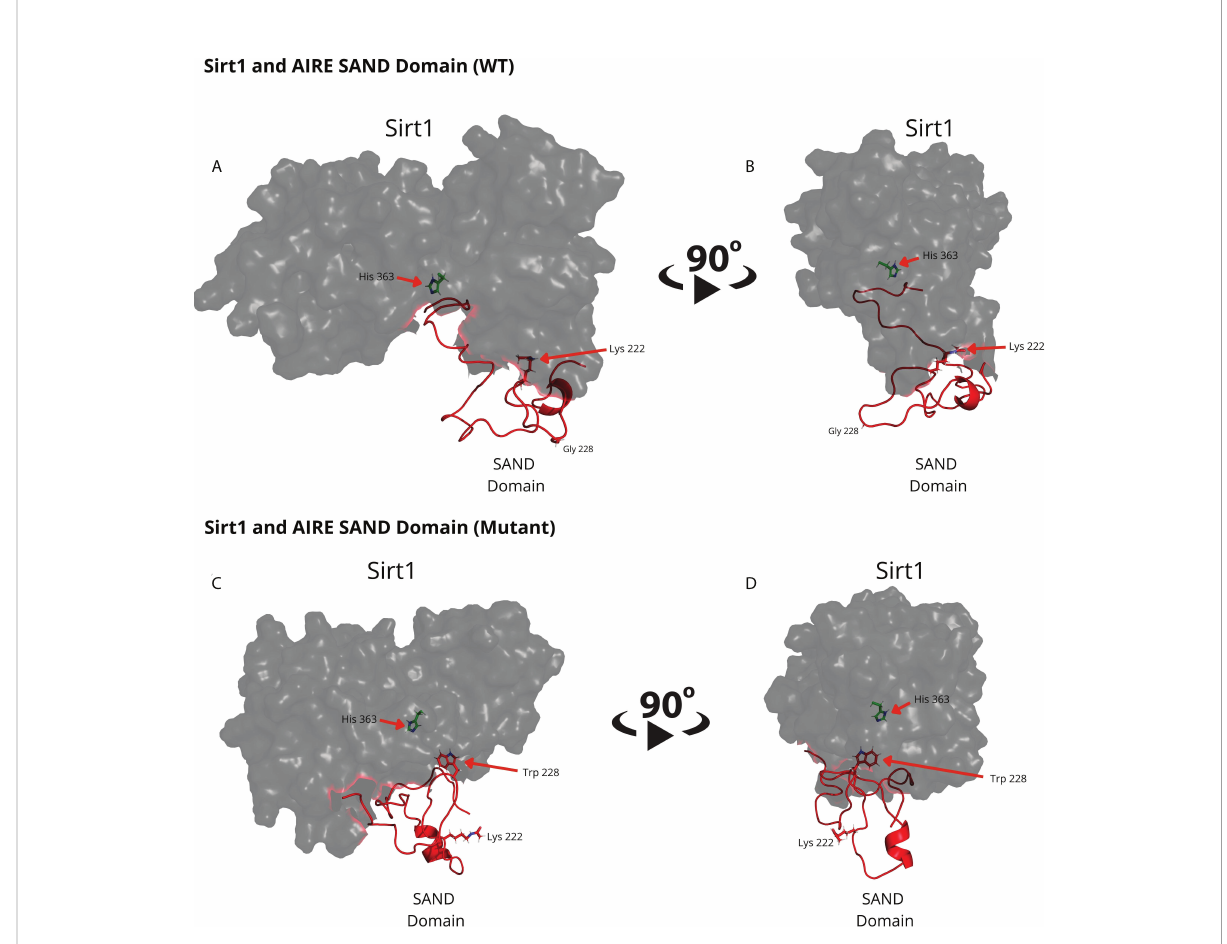
FIGURE 5 Molecular dynamics structures formed between (A, B) the WT AIRE SAND domain (in red) and SIRT1 protein (in dark grey) and (C, D) between Mutant AIRE SAND domain (in red) and SIRT1 (in dark grey). (A, B) Note that the acetylated K222 residue from the AIRE SAND domain (in red) is not directed to the SIRT1 H363 catalytic residue (side chain in green) after the analyzed dynamics time (1.0 microsecond) (C, D) . Considering the complex formed between the mutant AIRE SAND domain, at 1.0 microseconds of dynamics, the mutant residue W228, in the AIRE SAND domain, remained close to the catalytic H363 residue (side chain in green) of